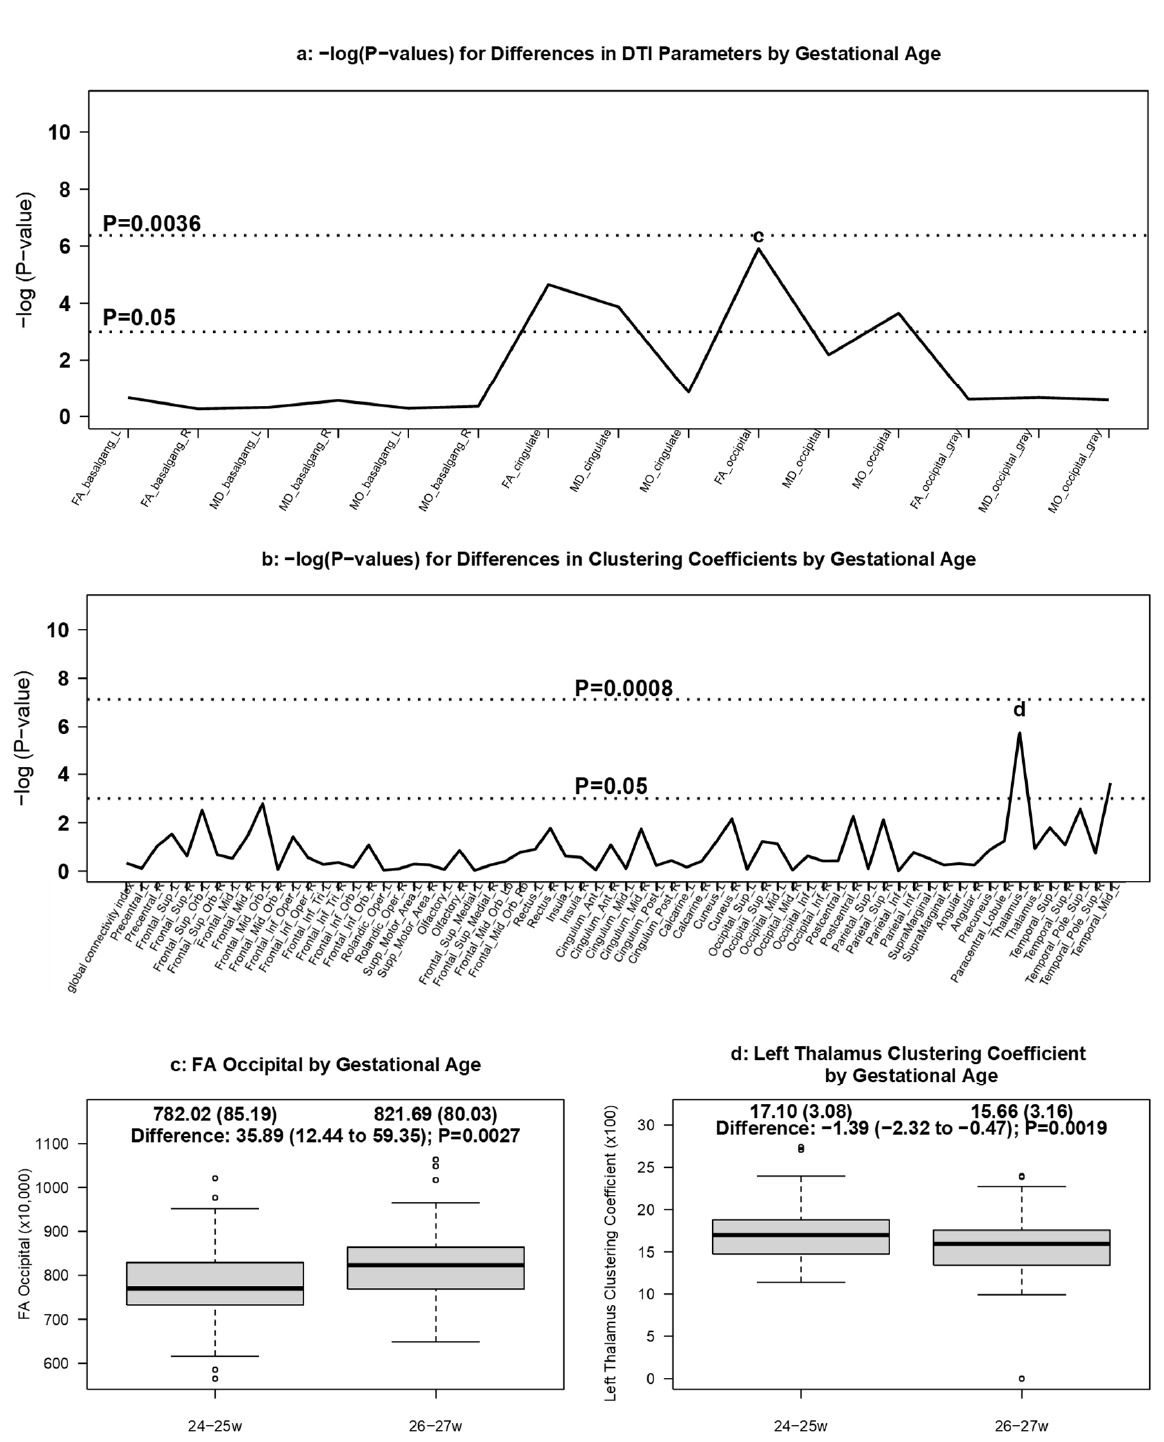
Figure 4. DTI measures by gestational age. Manhattan plots of [GEE-based Wald test] -log ( p -values) for differences in ( a ) regional DTI diffusion values and ( b ) clustering coefficients by GA. Panel ( c ) displays boxplots of differences in the FA measurements in the occipital white matter region by GA, and panel ( d ) presents boxplots of clustering coefficients in the left thalamus found to be different by GA.